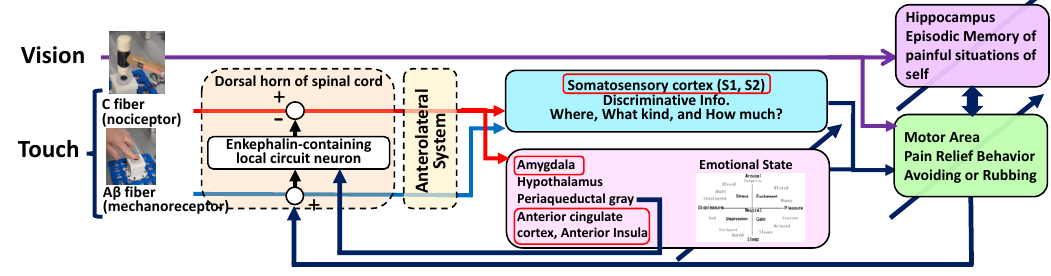
Figure 5. The early stage of pain